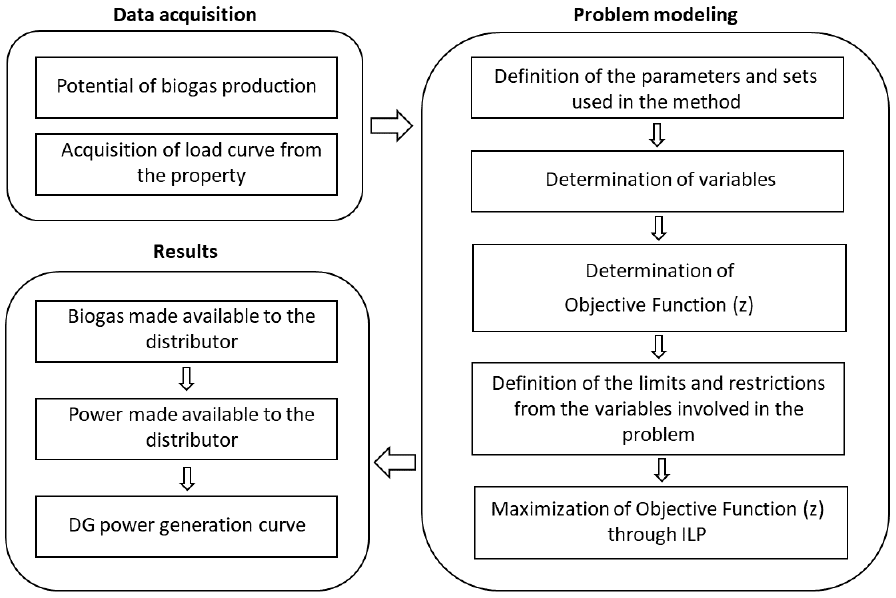
Figure 9. Development of mathematical modeling.